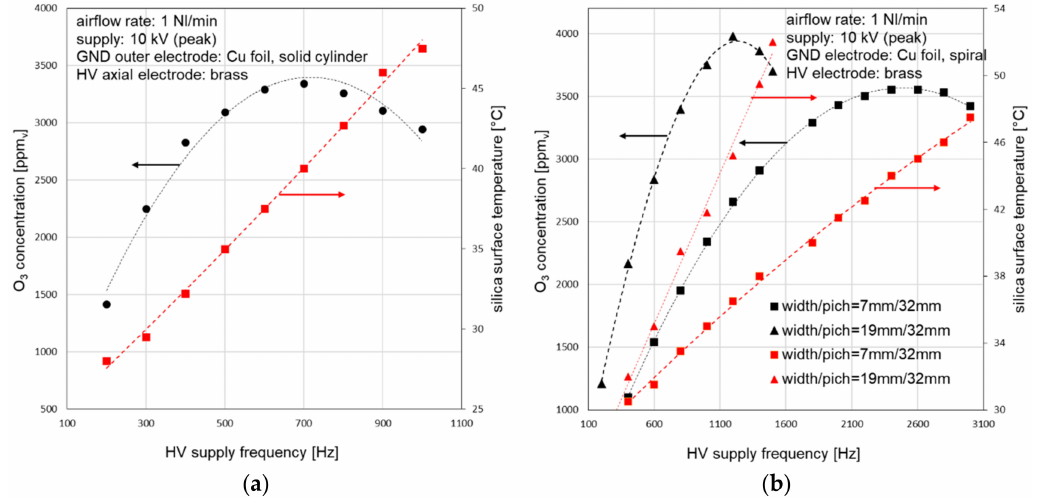
Figure 5. Variations of O 3 concentration and temperature in the volume DBD OG fitted with the internal brass electrode and outer Cu foil electrode of ( a ) solid design, ( b ) spiral design (supplied using